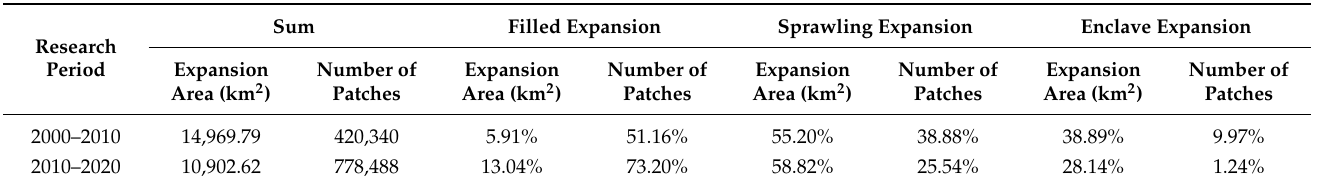
Table 2. The proportion of expansion areas and quantity of patches of new construction land in different expansion modes, 2000–2010 and 2010–2020.